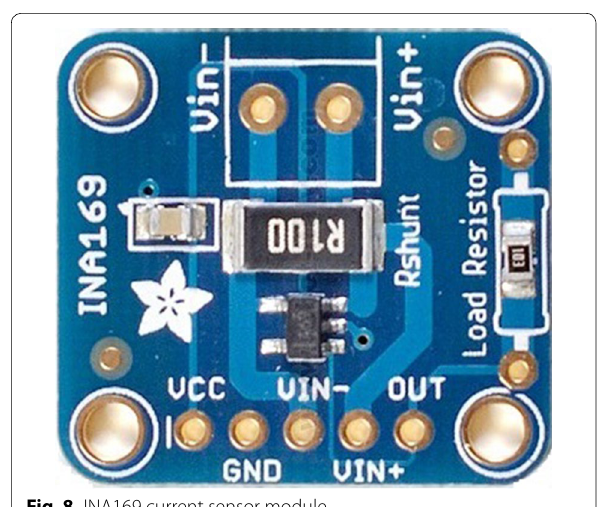
Fig. 8 INA169 current sensor module